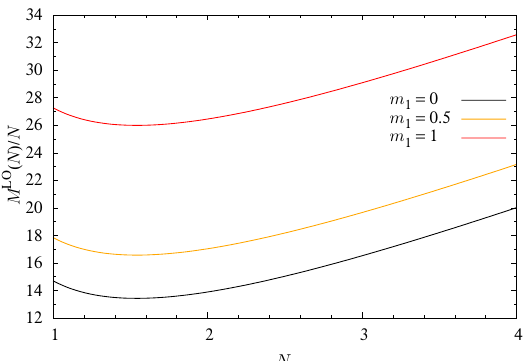
as a function of N